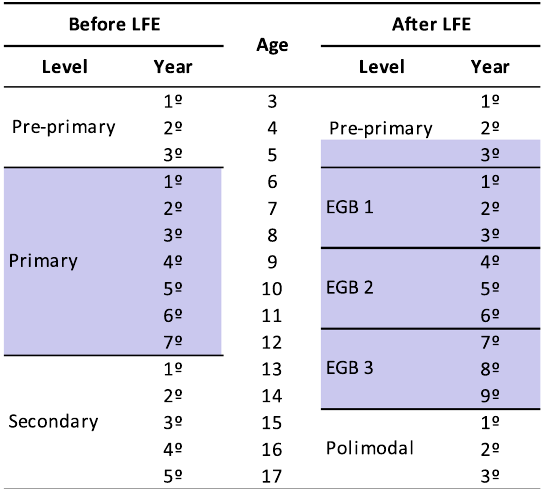
Table 2 Educational structure before and after the